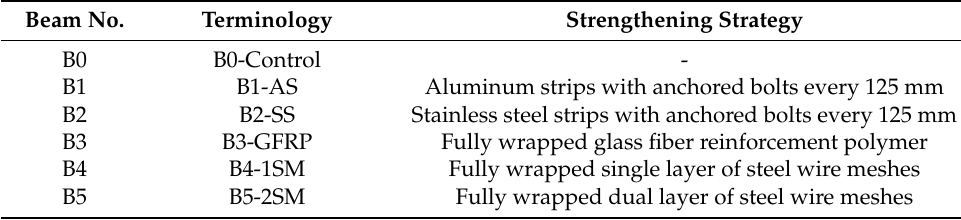
Figure 1. The reinforcement of the tested beams. Table 1. Program details for tested